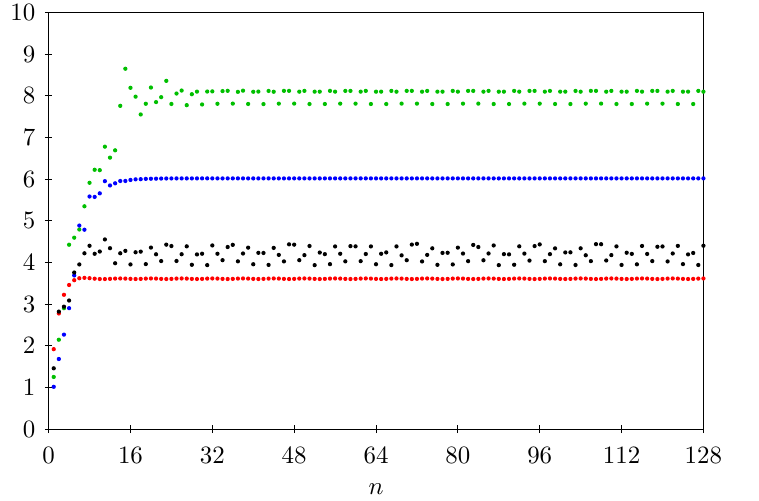
(1 / | d LP ( c ) /ρ c (∆ LP ( c )) − 1 | ) for c = 8 (black), c = 12 (red), c = 16 10 n n